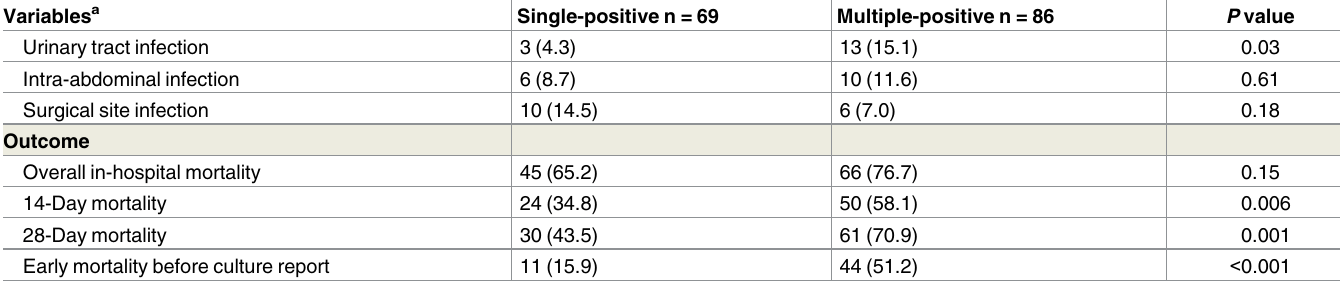
118) ( P = 0.18, 0.98, and 0.98,